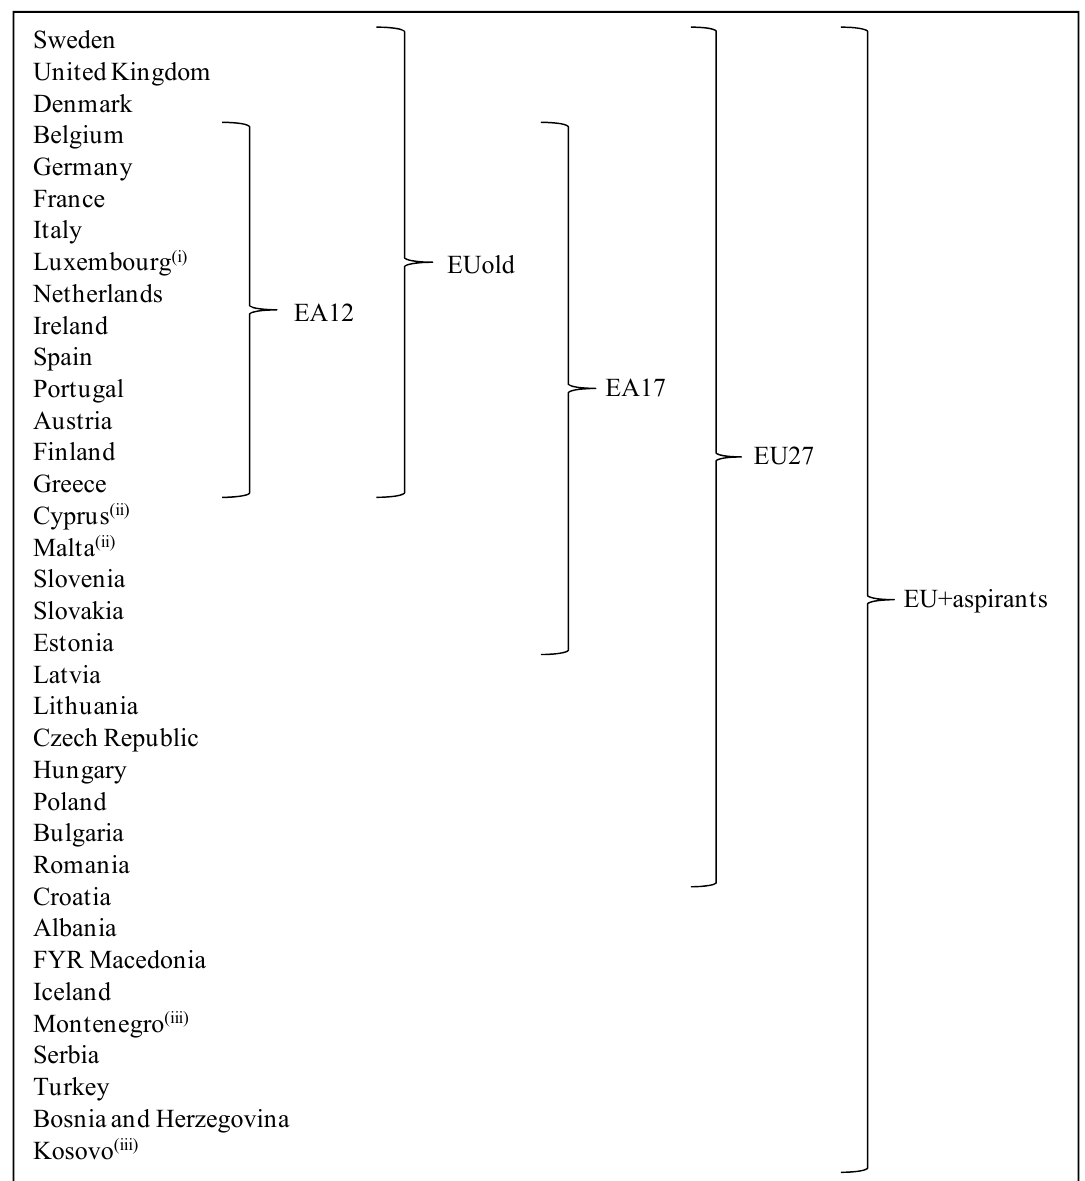
Figure 1 : European country groups (by the end of